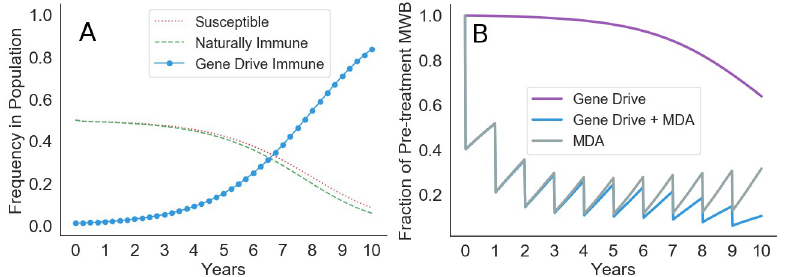
Fig 5. Combining gene drive with mass drug administration. (A) 35% reduction in mean worm burden (MWB) is observed in 10 years with gene drive alone. (B) Targeted administration of MDA at 60% annual reduction (efficacy � coverage) in MWB results in more rapid but temporary reduction than the use of gene drive. Sustained reductions are achieved with coincident MDA and gene drive treatment.